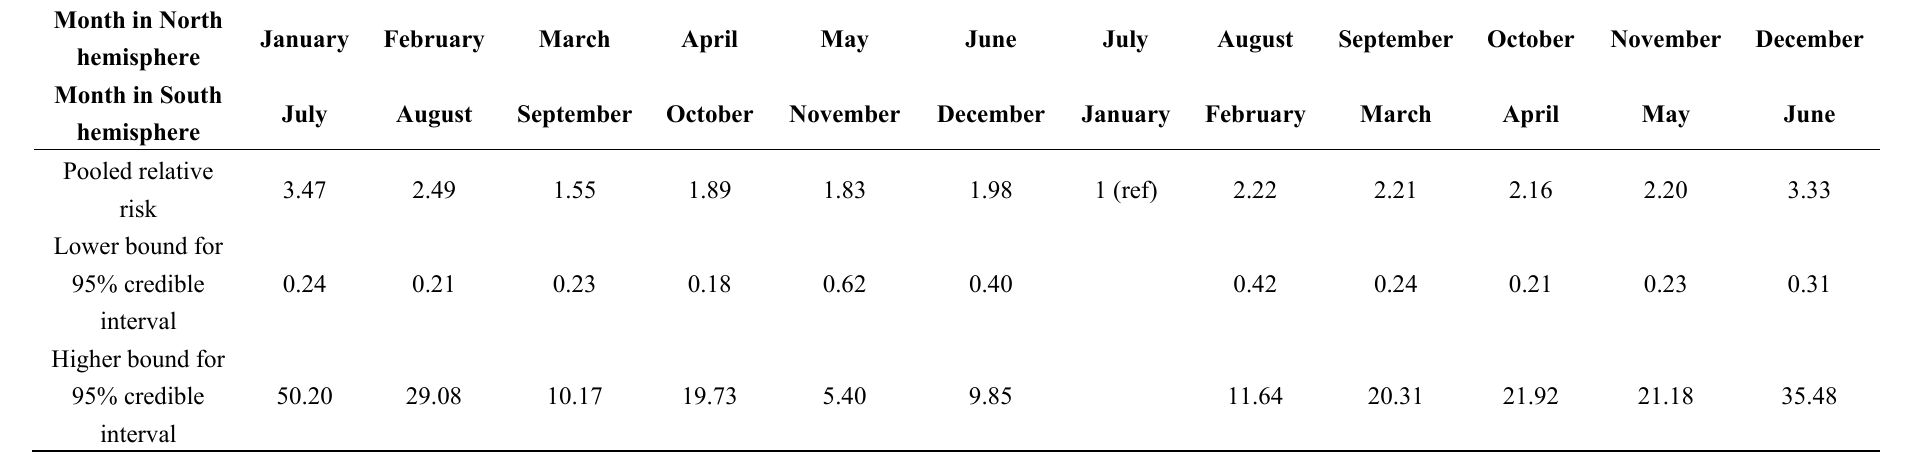
Table A10. Pooled relative risks and 95% credible interval for the association between month of birth on eclampsia incidence after excluding [34]. Month in North hemisphere Month in South hemisphere Pooled relative risk Lower bound for 95% credible interval